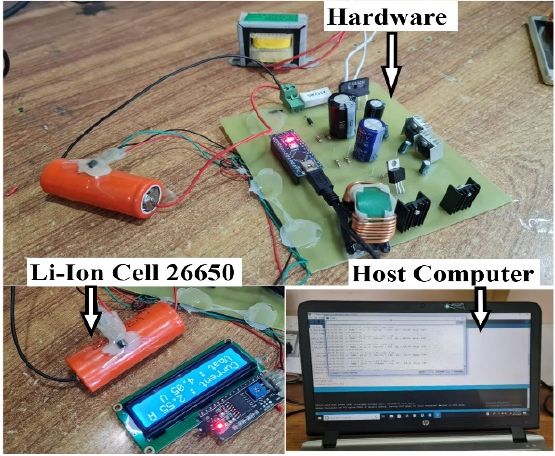
Figure 3. Annotated image of experimental setup.